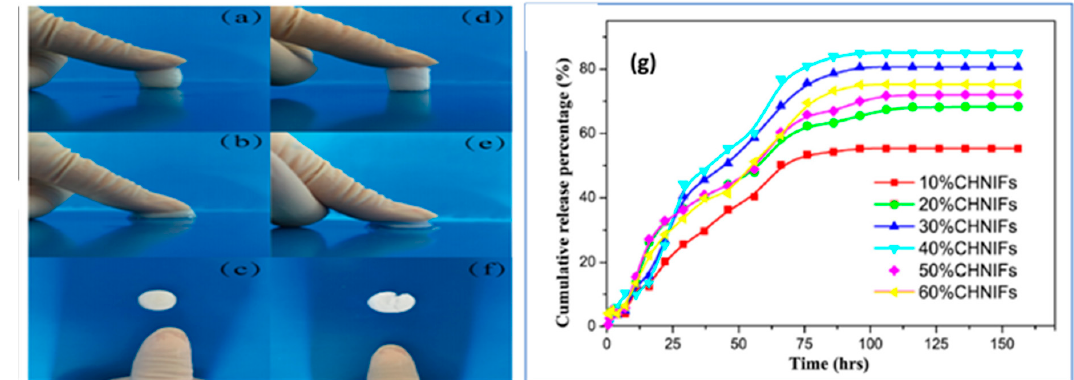
Figure 13. The pictures of PVA/CNW (30% CNWs, 1% GA) hydrogels ( a – c ) and pure PVA hydrogels ( d – f ) compressed by a thumb. ( g ) Release activities of BSA from the hydrogels at 25 °C [79].